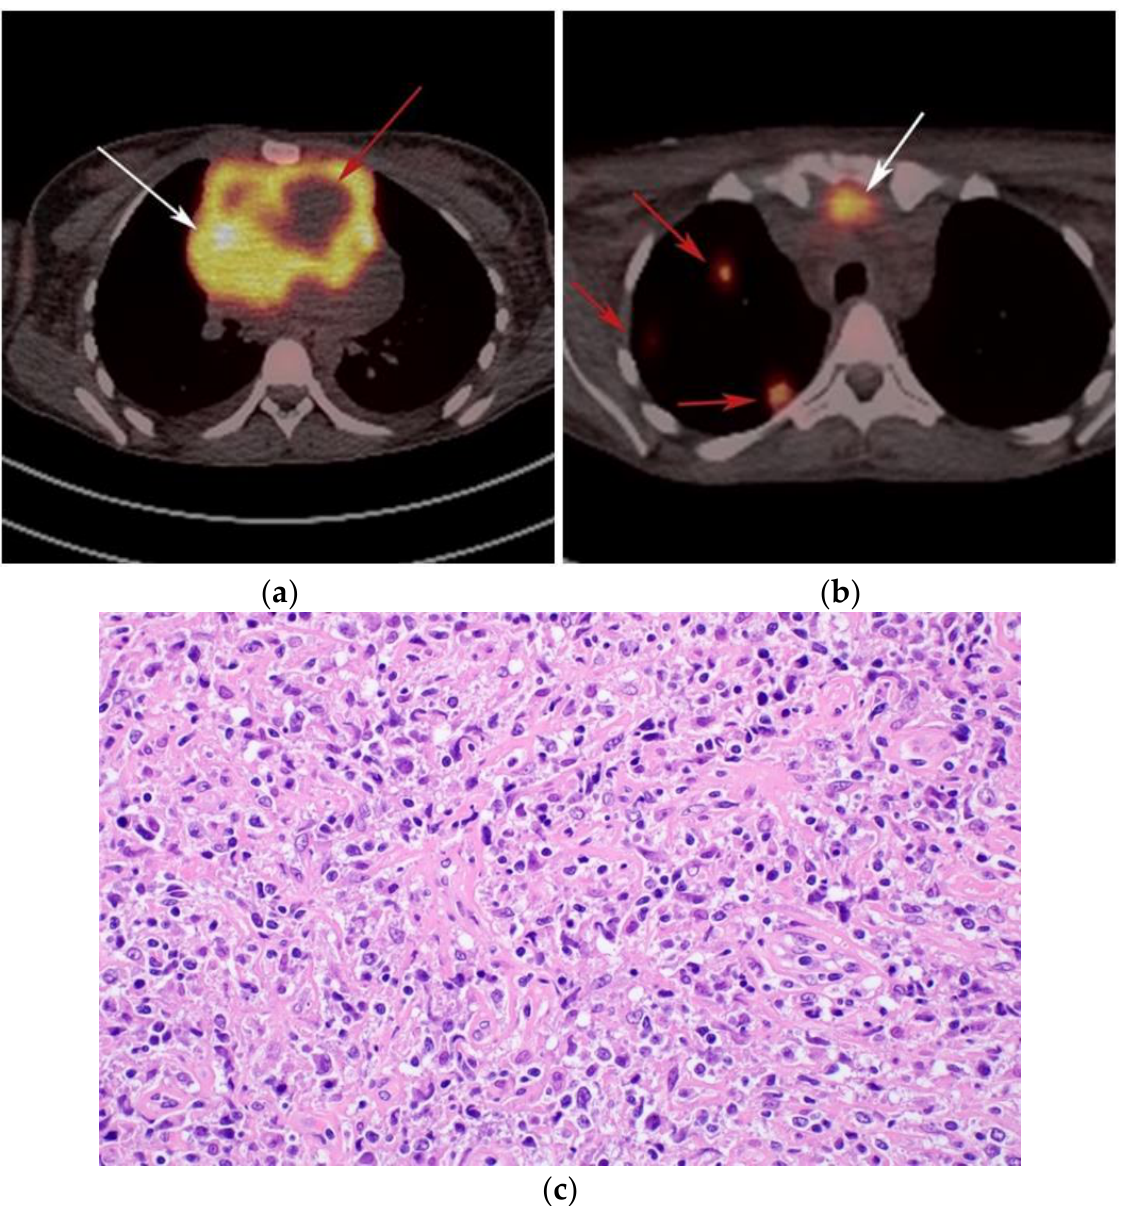
Figure 6. Imaging in a different patient with known diagnosis of primary mediastinal B-cell lymphoma. ( a ) Axial FDG PET/CT images show the hypermetabolic anterior mediastinal mass (white arrows), and there is also central areas of absent metabolic activity within the mass (red arrow), correlating with areas of fibrosis, a finding that is essential in prebiopsy planning to avoid false negative results. ( b ) Axial FDG PET/CT images show hypermetabolic right upper paratracheal nodes (white arrows) and several additional hypermetabolic pulmonary and pleural-based nodules within right upper lung (red arrows). ( c ) H&E section shows that the tumor is composed of large, atypical cells with reniform or multi-lobulated nuclei with abundant clear cytoplasm. Note the lymphoma cells are compartmentalized by the prominent sclerotic bands of fibrosis. (Original magnification 400x, H&E stain).